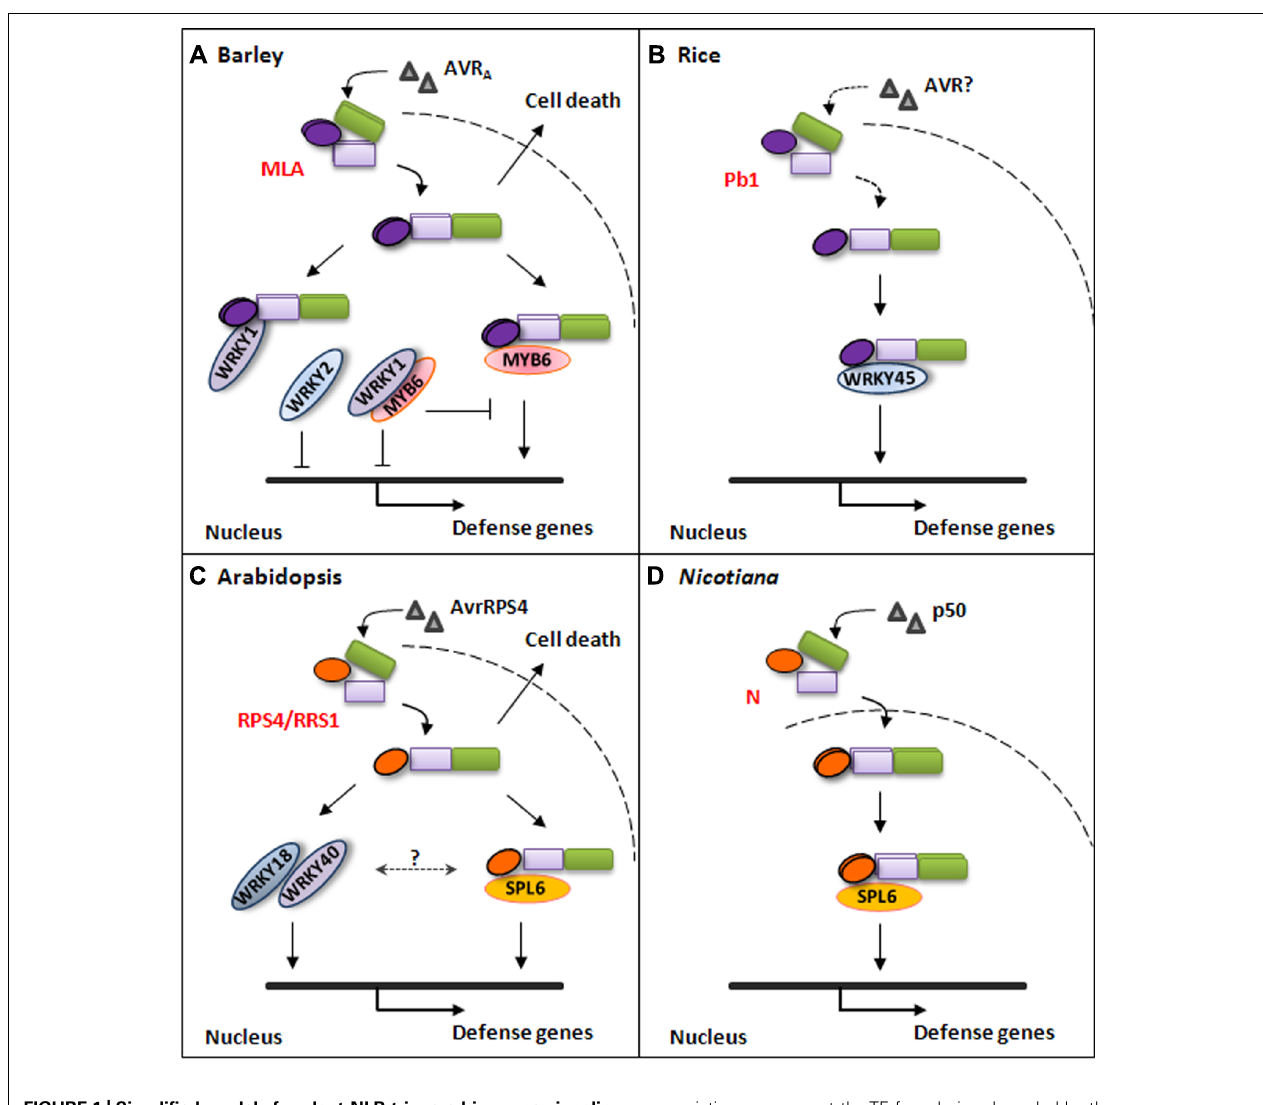
FIGURE 1 | Simplified models for plant NLR-triggered immune signaling pathways . (A) Barley MLA immune receptor recognizes cognate AVR A effector from B. graminis fungal pathogen and triggers disease resistance signaling in the nucleus or cell-death signaling in the cytoplasm. The activated MLA interacts with WRKY1 through its N-terminal CC domain to release MYB6 and by itself directly interacts with MYB6 to initiate defense gene expression. Barley WRKY1 and WRKY2 are repressors of defense responses. (B) Rice atypical NLR Pb1 interacts with WRKY45 to mediate immune responses against the rice blast fungal pathogen. The Pb1-WRKY45